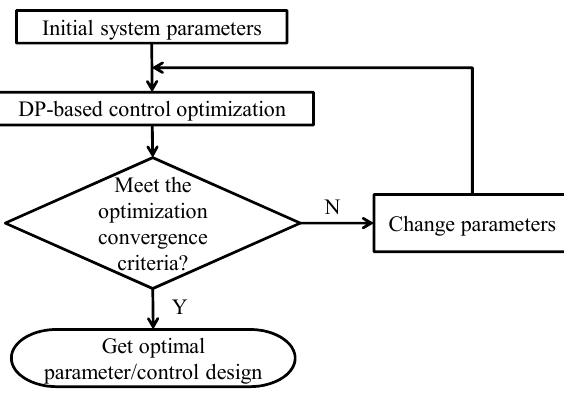
Figure 6. Bi-level combined optimization